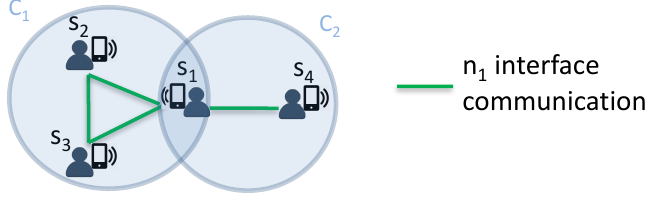
Figure 3. Example of node belonging to two